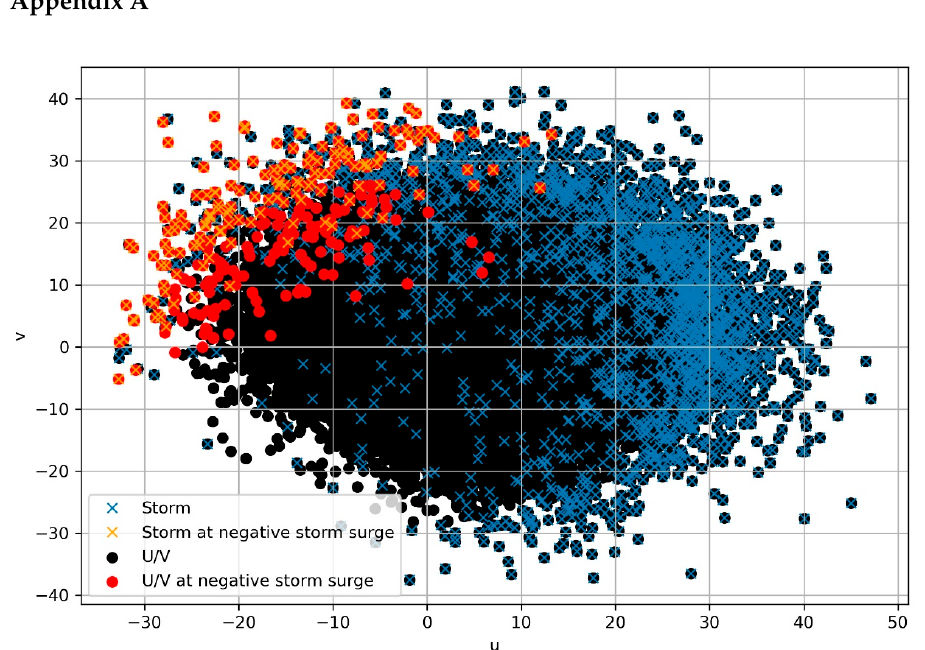
Figure A1. Distribution of the U and V components of the geostrophic wind from the LWT classifi- cation for daily means (black) and for the 24-h mean before an ELW (red). Marked also is whether a gale was present at that time (blue and yellow ‘x’, respectively).